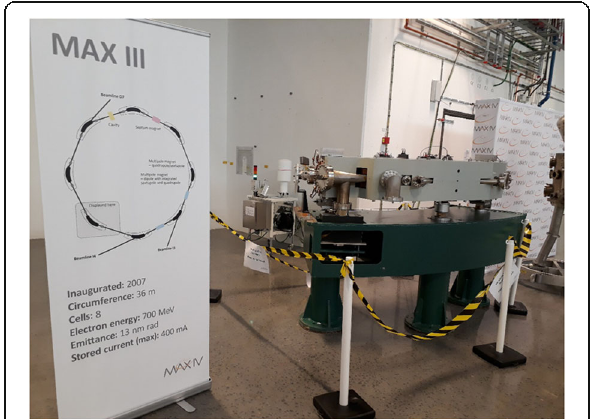
Fig. 7 Compact unit cell in MAX-III